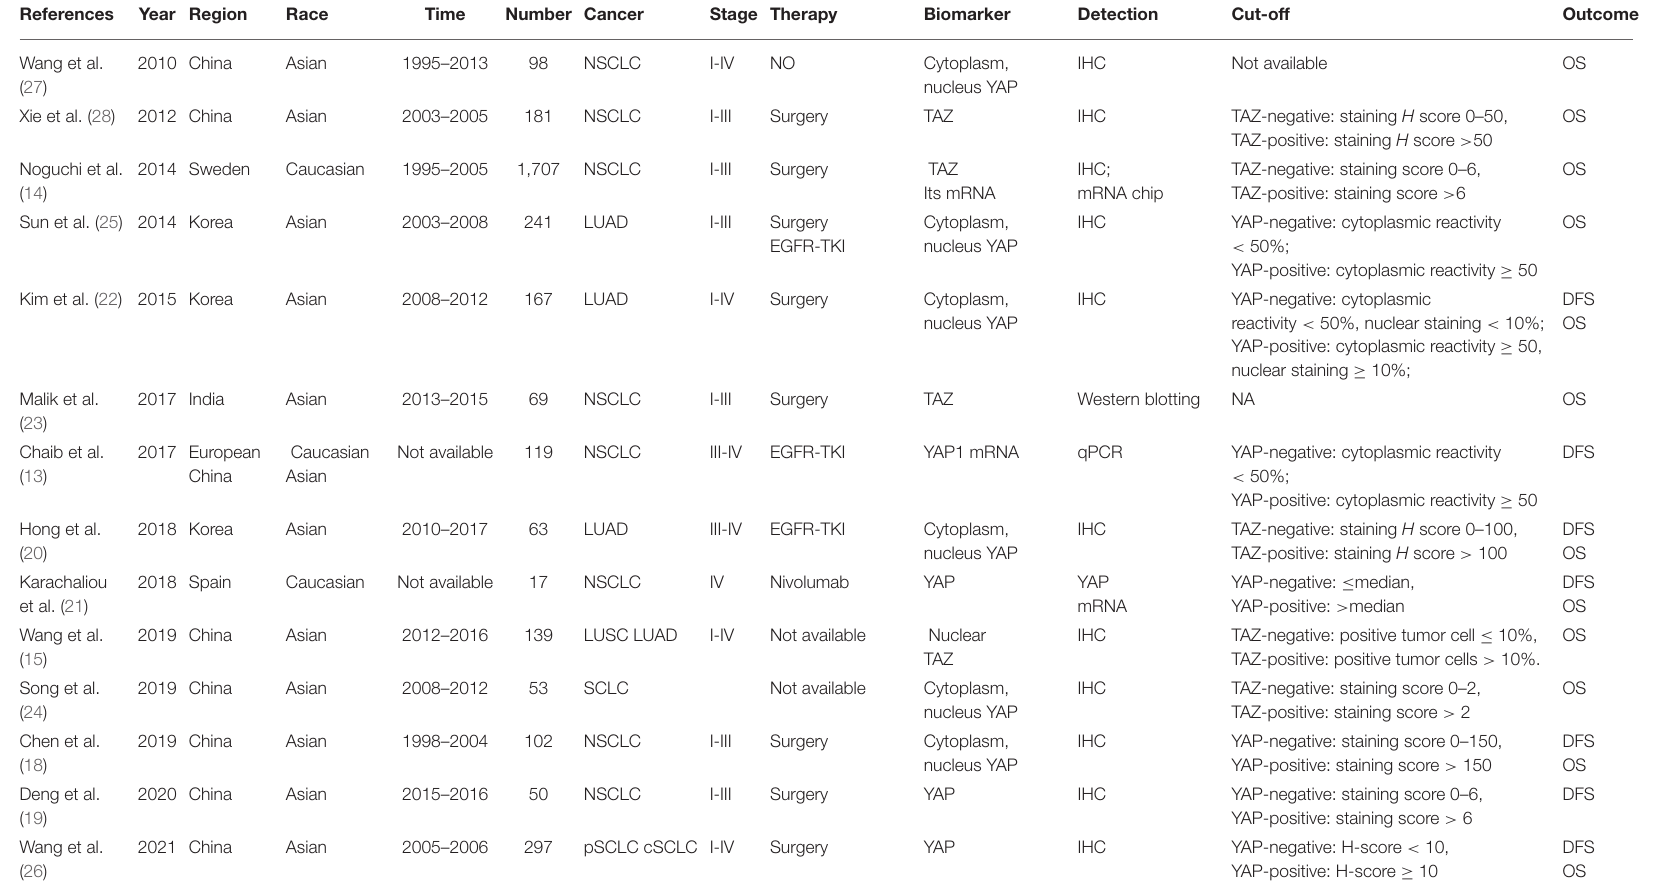
TABLE 1 | The baseline characteristics of eligible